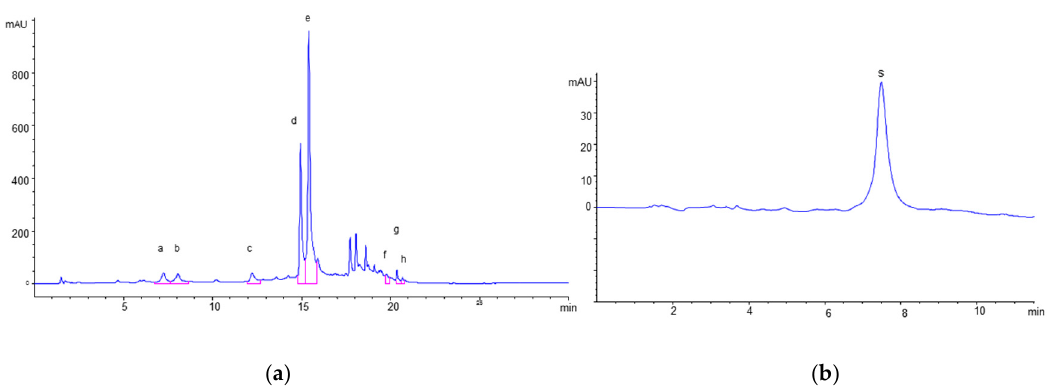
Figure 2. Chromatograms of S. amplexicaulis bark extract: ( a ) a-chlorogenic acid; b- p -hydroxybenzoic acid; c-epicatechin; d- p -coumaric acid; e-rutin; f-quercetin; g-trans-cinnamic acid; h-naringenin; ( b ) s-salicin.